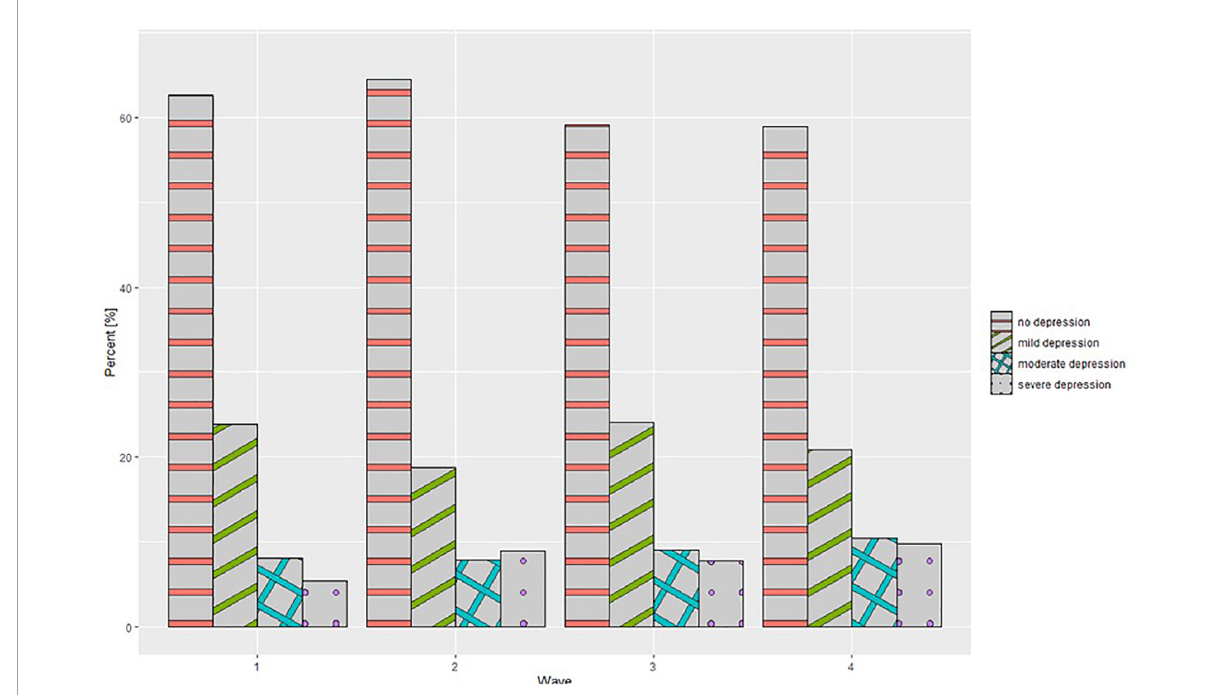
FIGURE2 Beck Depression Inventory II (BDI-II) interpretation at different stages of the